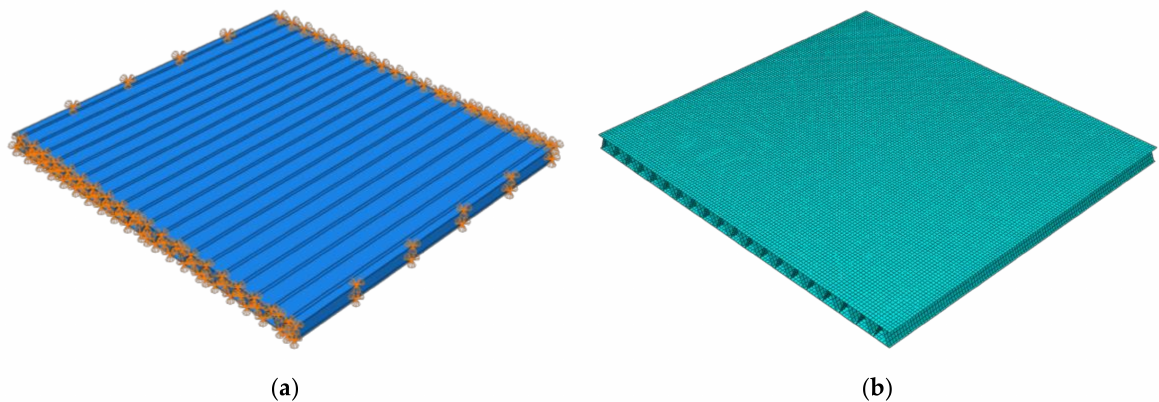
Figure 5. Schematic of the corrugated sandwich panel. ( a ) Finite element model with fixed constraint, and ( b ) meshing of the model.